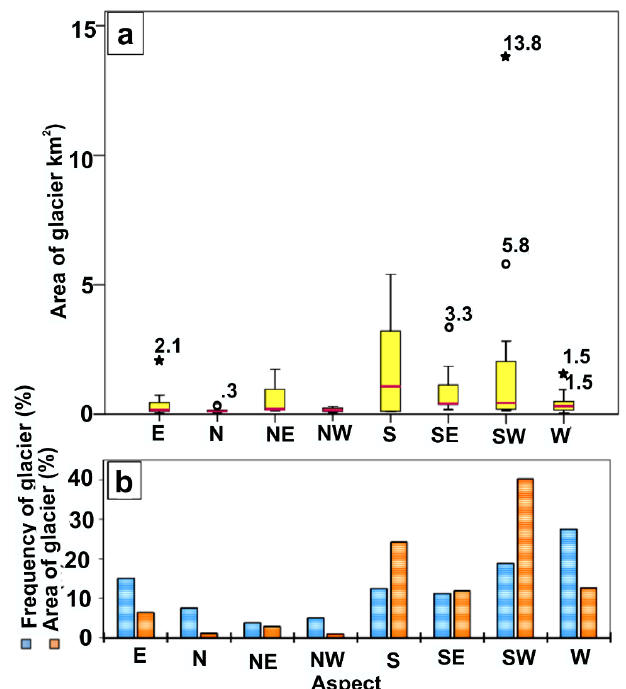
Figure 6. Aspect-wise distribution of glacier area and frequency (2016). ( a ) Glacier area distribution on different aspects with median line (red color) and extreme values, ( b ) Percentage of glacier frequency and glacier area according to aspect.